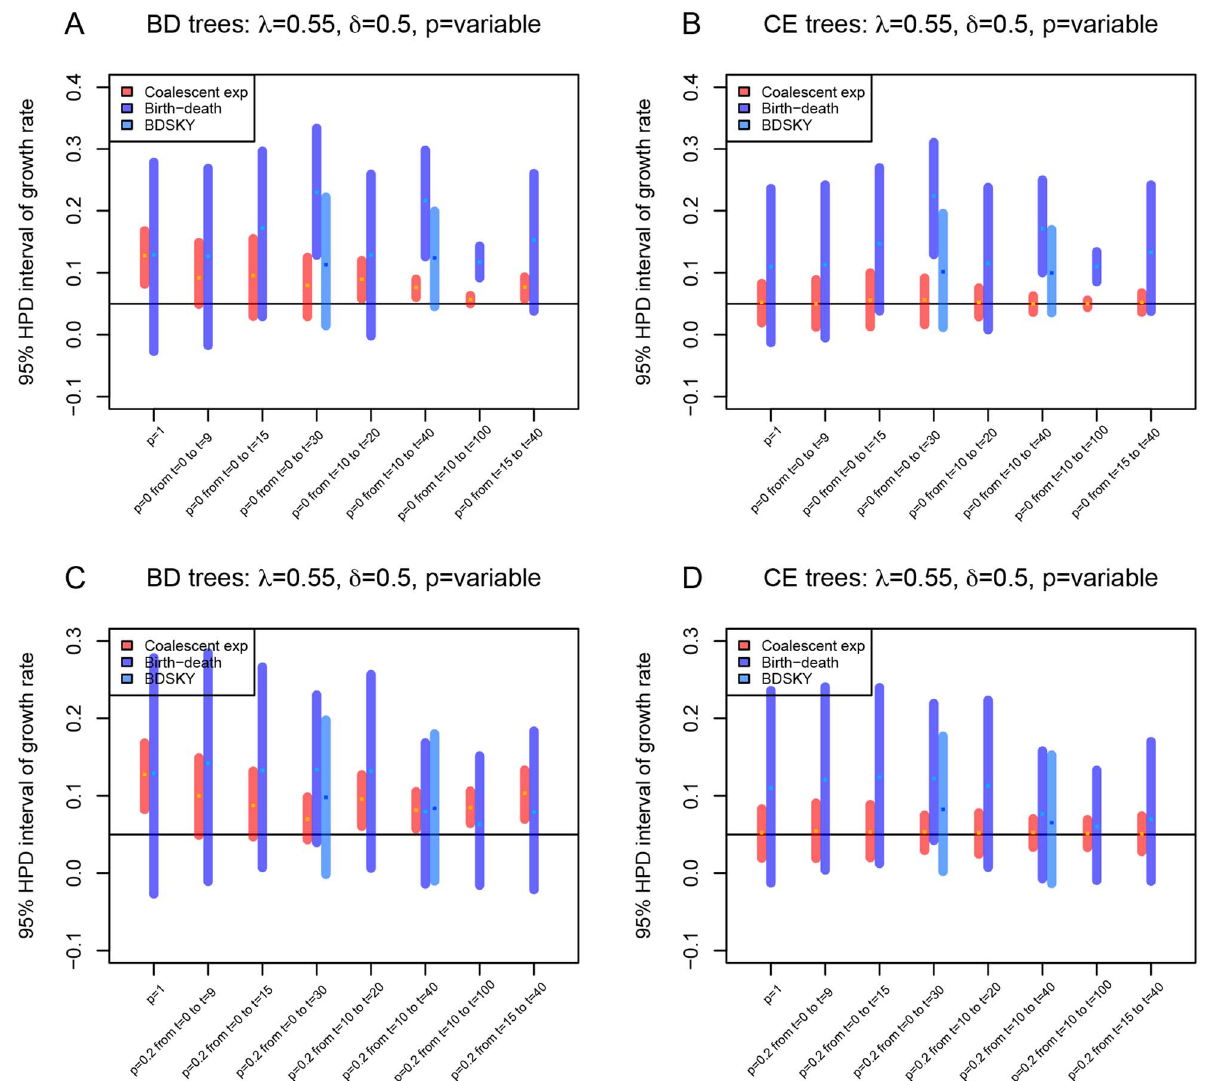
Figure 3. Influence of sampling scheme on the growth rate parameter estimation. For setting l ~ 0 : 55, d ~ 0 : 5 ( R 0 ~ 1 : 1 ), we modified the birth-death tree simulations to include periods of higher ( p ~ 1 ) and lower sampling (either p ~ 0 , subfigures A and B, or p ~ 0 : 2 , subfigures C and D). We simulated 100 birth-death trees (A and C) and corresponding coalescent trees (B and D) under various sampling schemes (see x-axis annotation). We display a summary in form of the median values of the start and the end of the 95% HPD intervals, and the median of the medians of the posterior estimates for all 100 trees per setting. For the settings where the constant rate birth-death method produced very severe biases, we also analysed the trees with the birth-death skyline model with 10 intervals for the sampling probability (BDSKY, light-blue lines). The summary for trees simulated under constant sampling p ~ 1 throughout, is represented on the very left of each figure ( p ~ 1 on the x-axis). Next, we varied the sampling as to e.g. sample no tips ( p ~ 0 ) in the early phases ( t ~ 0 until t ~ 9 ) when going forward in time and then sampling all the tips that die ( p ~ 1 ) from t ~ 9 onward (corresponding to the setting denoted as ‘‘p=0 from t=0 to t=9’’). at time T with sampling probability r ~ f 0 : 01,0 : 5,1 g . For